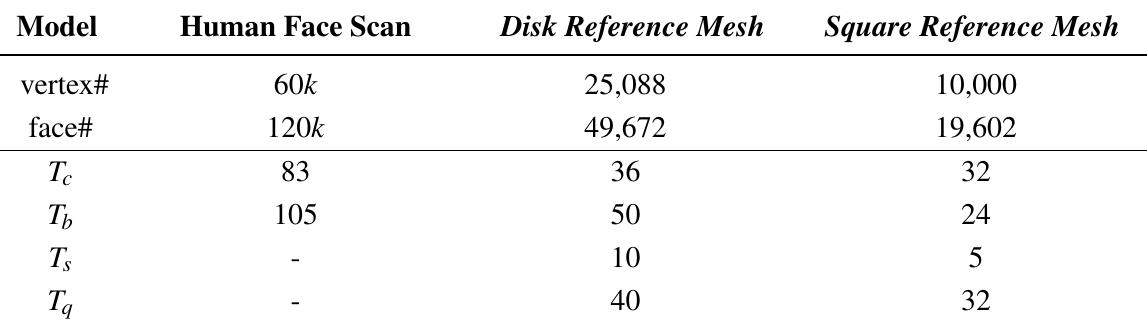
Table 1. Computational time